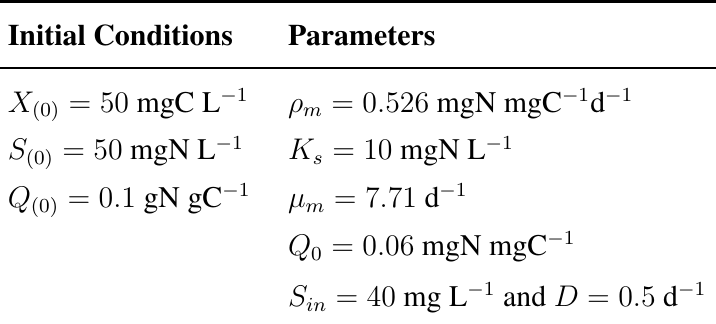
Table 2. Initial conditions and